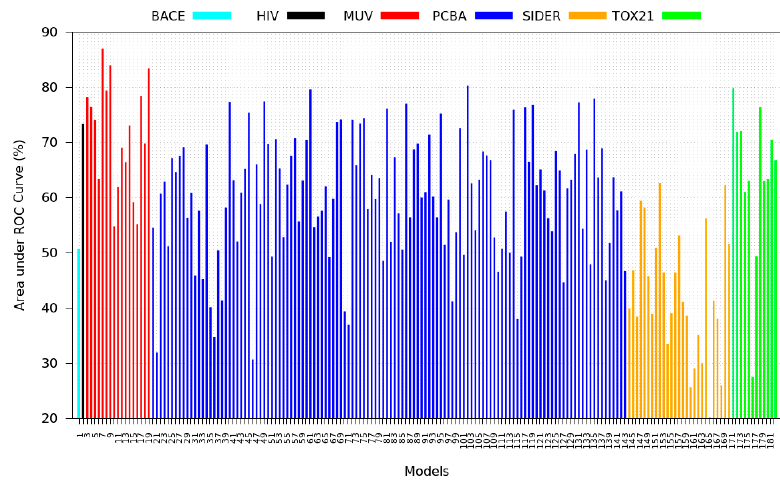
Figure A5. Discriminative capability (MSC) of each pre-trained source model in regards to the bio-activity of the target dataset’s molecules.